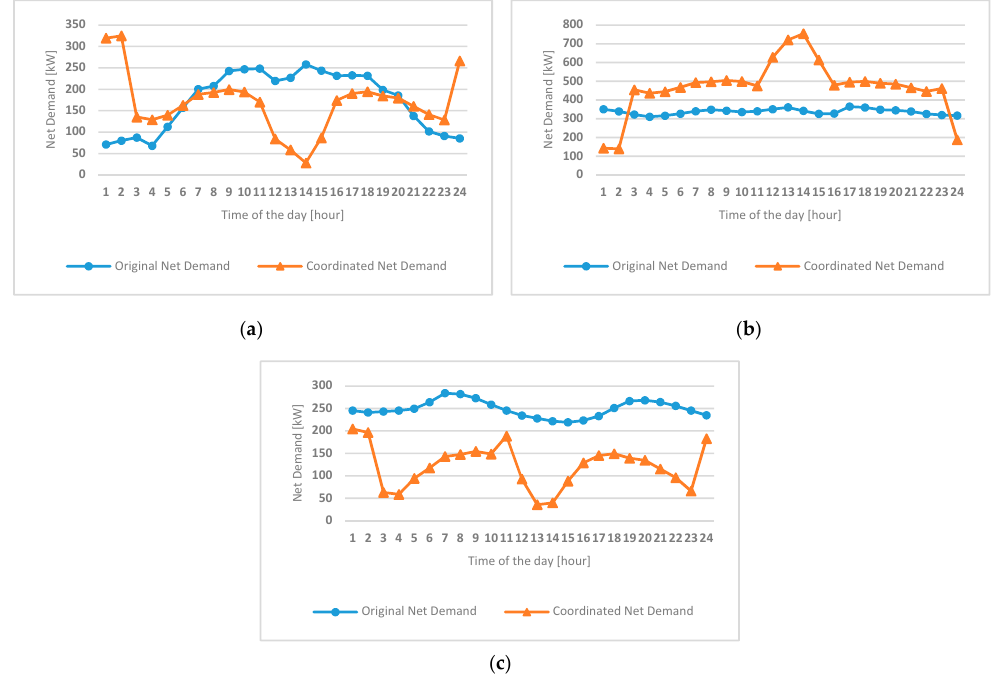
Figure 12. Changes in net-demand for each microgrid ( a ) MG1, ( b ) MG2, ( c ) MG3.